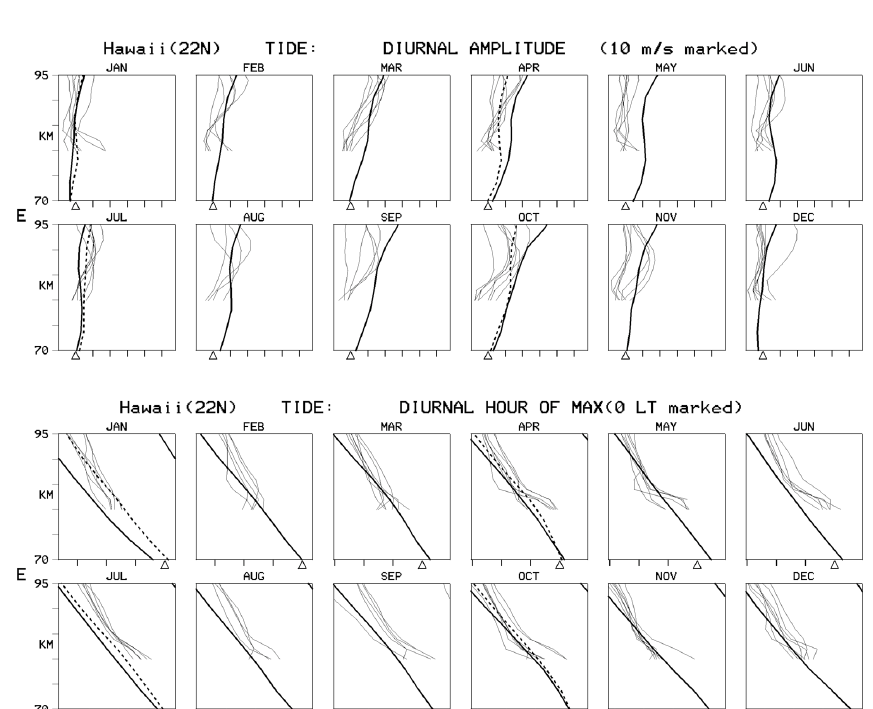
Fig. 6. Profiles of the Diurnal (24h) Tide amplitudes and phases for the zonal ( E ) component at Saskatoon. The thin lines are for the 6 years of MFR data, the dashed lines for GSWM (original 1995) and the thick lines for GSWM2000. The triangles on the am- plitude plots refer to the 10m/s val- ues. For the phase plots, the total phase displayed is 24h; the triangles are at 00:00LT and their positions are chosen to minimize the number of phase dis- continuities (“wrap-around”).